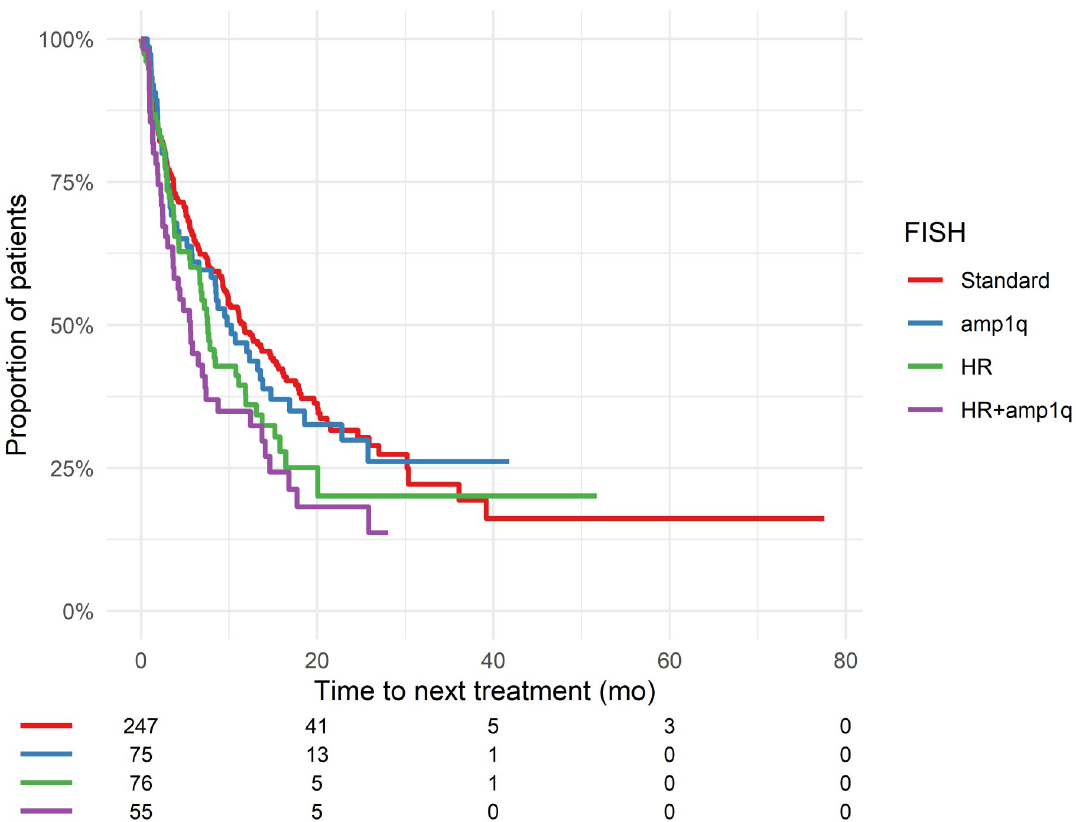
Fig 3. Time to next treatment of the first daratumumab therapy depending on cytogenetic abnormalities. Patients at risk is shown below each figure. High-risk CA was defined as the presence of del17p, t(4:14) or t(14:16). Abbreviations: mo = months. A:TNT for for all combinations of daratumumab-containing line of therapy depending on CA. Compared with patients with standard-risk CA, patients with amp1q had similar TNT (p = 0.65). Patients with high-risk CA had a trend towards shorter TNT (p = 0.003).